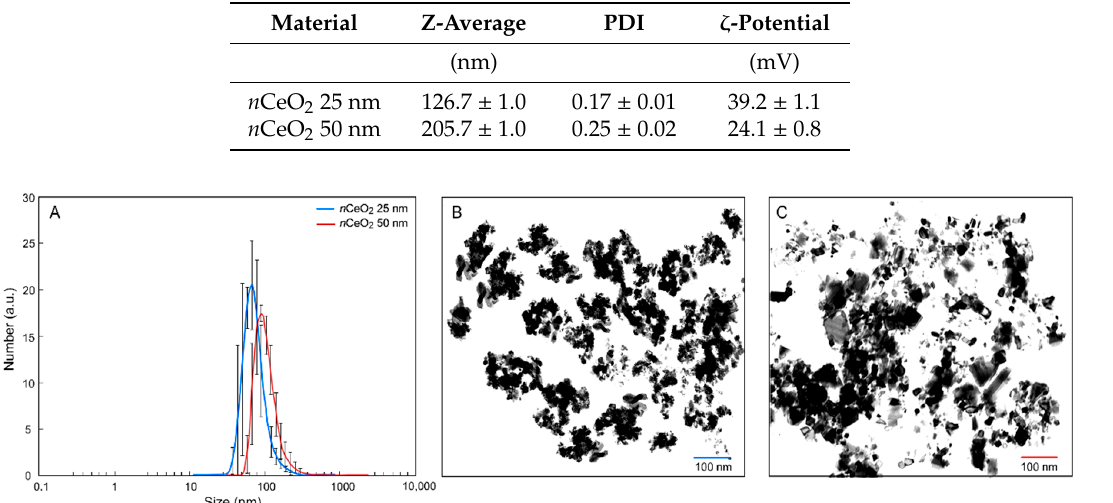
Figure 1. ( A ) Particle size distribution measured by dynamic light scattering (DLS) on suspensions of n CeO 2 25 nm and 50 nm; ( B ) transmission electron microscopy (TEM) image of n CeO 2 25 nm; ( C ) TEM n CeO 2 50 nm.